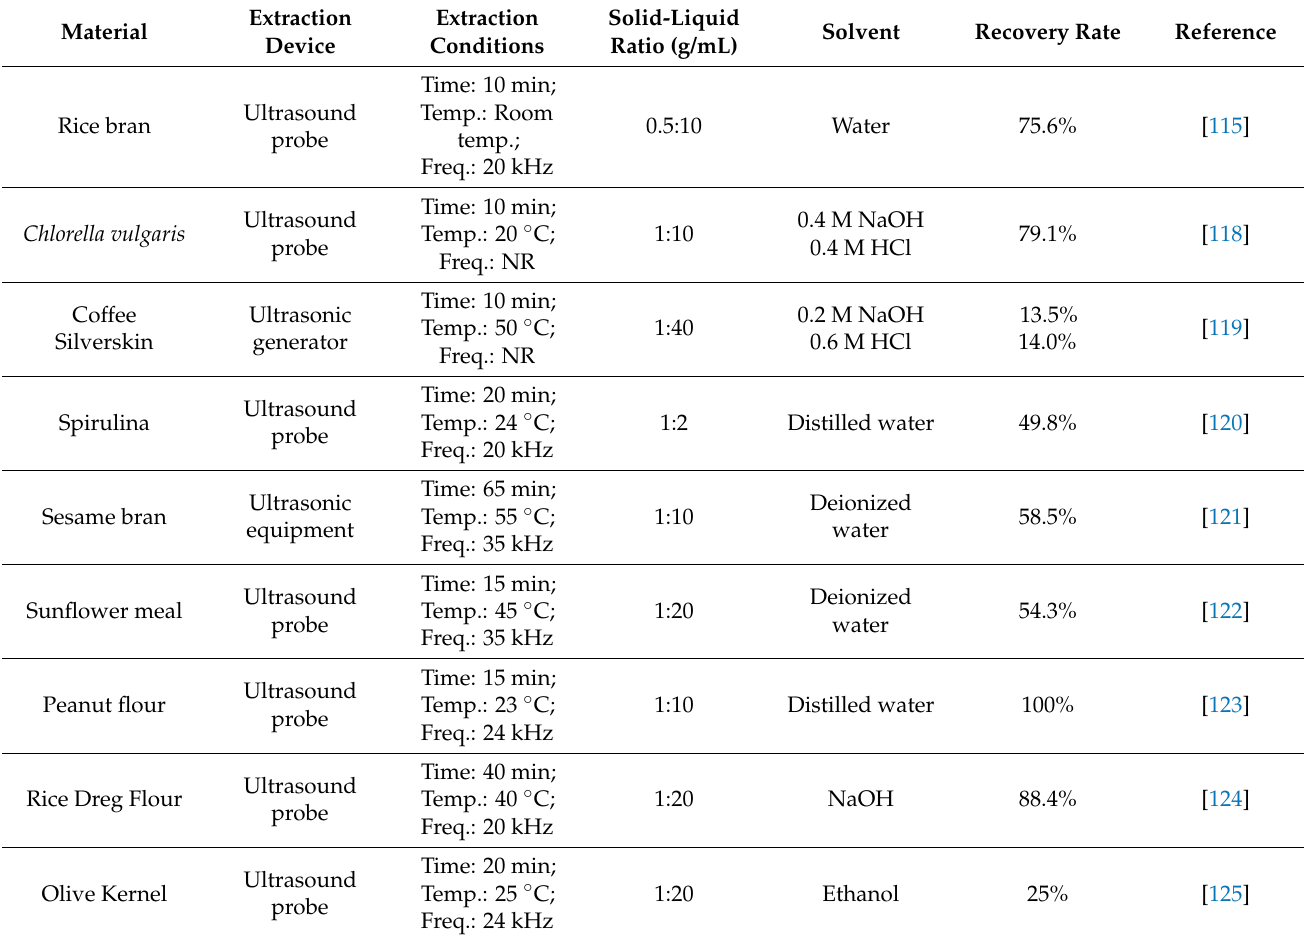
Table 5. Extraction of proteins by ultrasonic-assisted